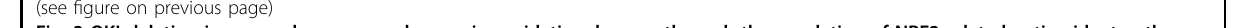
Fig. 3 QKI deletion in macrophages caused excessive oxidative damage through the regulation of NRF2-related anti-oxidant pathways. A Representative images of IHC staining of iNOS in colon tissue of WT-DSS and KO-DSS mice. Scale bars: 200 μ m. The staining intensity of the positive area (include mucosa and CLP) was quanti fi ed by ImageJ software (National Institutes of Health, Bethesda, MD) and illustrated with bar charts ( n = 3/ group). B The percentage of ROS + macrophages collected from CLP of WT-DSS and KO-DSS groups were detected by fl ow cytometry and the cells were gated from CD45 + CD11b + . C Statistical results of macrophages with high level of ROS. D The level of ROS of RAW 264.7 cells with QKI5 knockout (shQKI5, and shNC was a scramble control) which stimulated by LPS (100 ng/mL) for 24 h were detected by ROS probe (red). Scale bars: 20 μ m. E NOX2, p22, and RAC1 proteins expression in shNC and shQKI5 cells treated with LPS for 24 h evaluated by western blotting. F Quanti fi cation of the band intensity of NOX2, p22, and RAC1. G Western blotting analysis of the expression of NRF2, KEAP1, GCLC, HMOX1, NQO1 in control and shQKI5 cells treated or not with LPS for 24 h. H Quanti fi cation of the band intensity of NRF2, KEAP1, GCLC, HMOX1, and NQO1. All bars represent the mean of measurements from three independent experiments, and the error bars indicate ±SEM; * P < 0.05, ** P < 0.01, *** P < 0.001, “ ns ” indicates not signi fi cant, two-tailed Student ’ s t test ( A , C , D ) and one-way ANOVA with Tukey ’ s multiple comparisons ( F , H